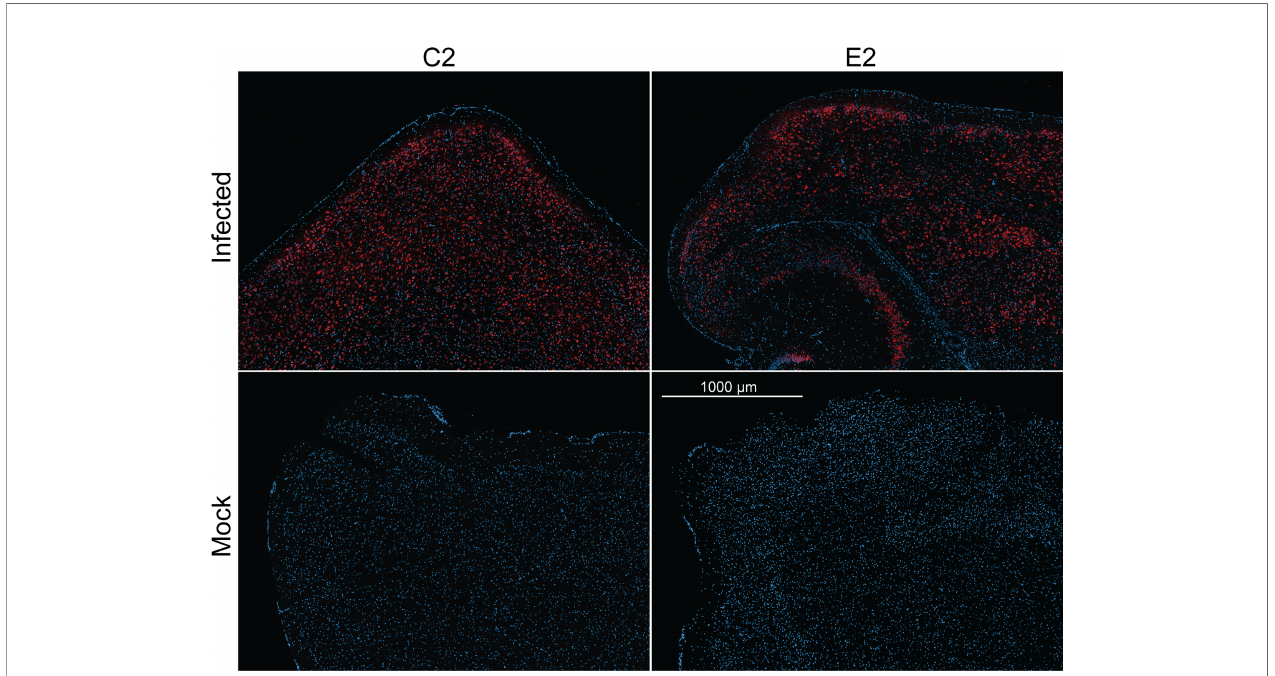
FIGURE 5 | Immuno fl uorescence staining of naïve or infected brain tissue. K18-hACE2 mice were previously challenged with an ancestral strain of SARS-CoV-2 (hCoV-19/Australia/VIC01/2020). Paraf fi n embedded sectioned brain tissue was then stained with either C2 Fc or E2 Fc nanobodies (red) & DAPI (blue) to detect N antigen and nucleus,